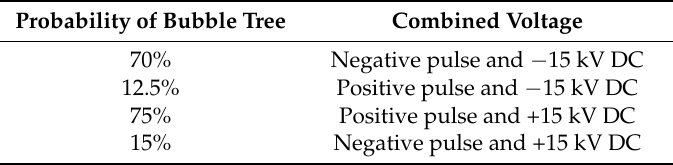
Table 2. Probability of bubble tree under different combined voltage with 10 min prestressing DC.